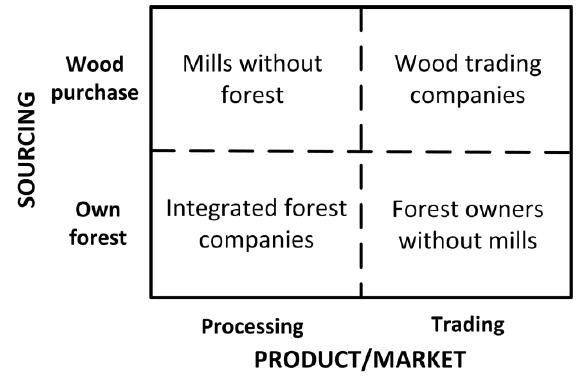
Figure 1. A classification of company situations depending on sourcing and product/market among Swedish forest products